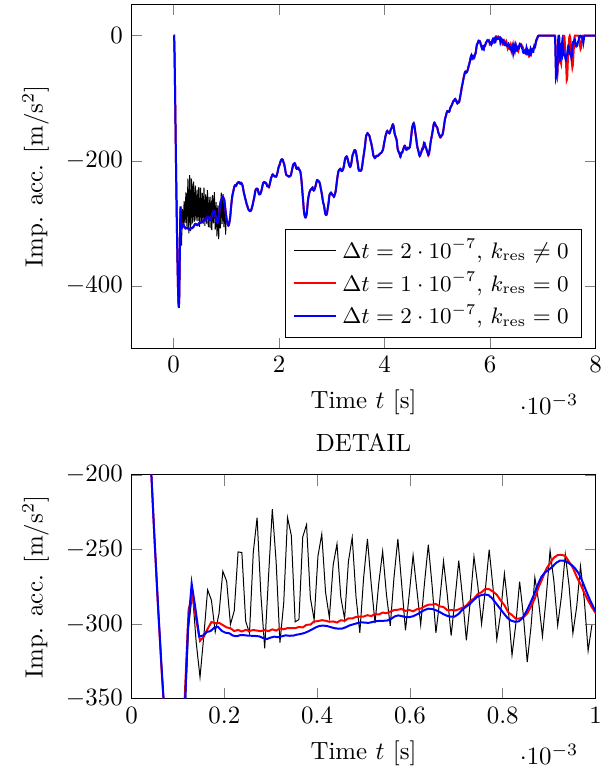
Figure 8. Evolution of impactor acceleration for two different time steps (red and blue) and for case k res 6 = 0 (black) with detail